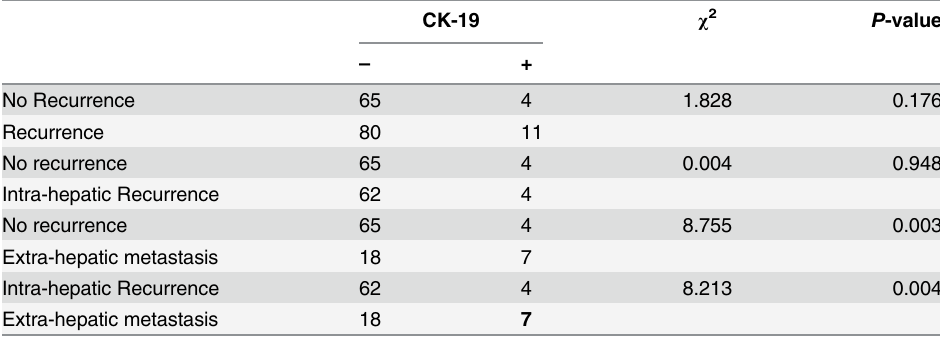
Table 4. Relationship between CK-19 expression and location of recurrence in patients with an AFP concentration of < 400 μ g/L ( n = 160).